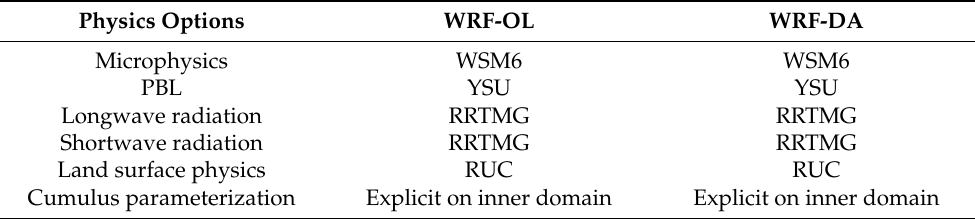
Table 1. Parametrization schemes adopted for subgrid-scale